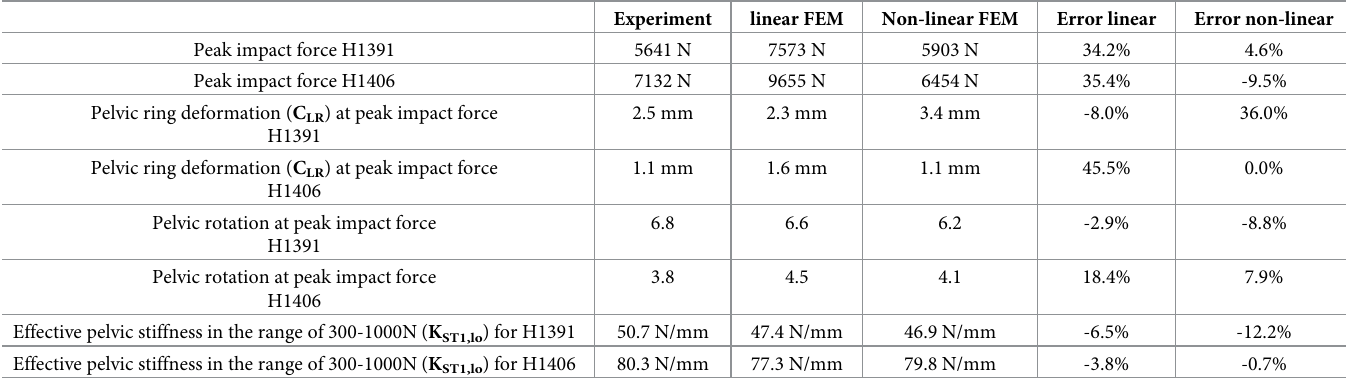
Table 2. Comparison of experimentally and FEM derived results.